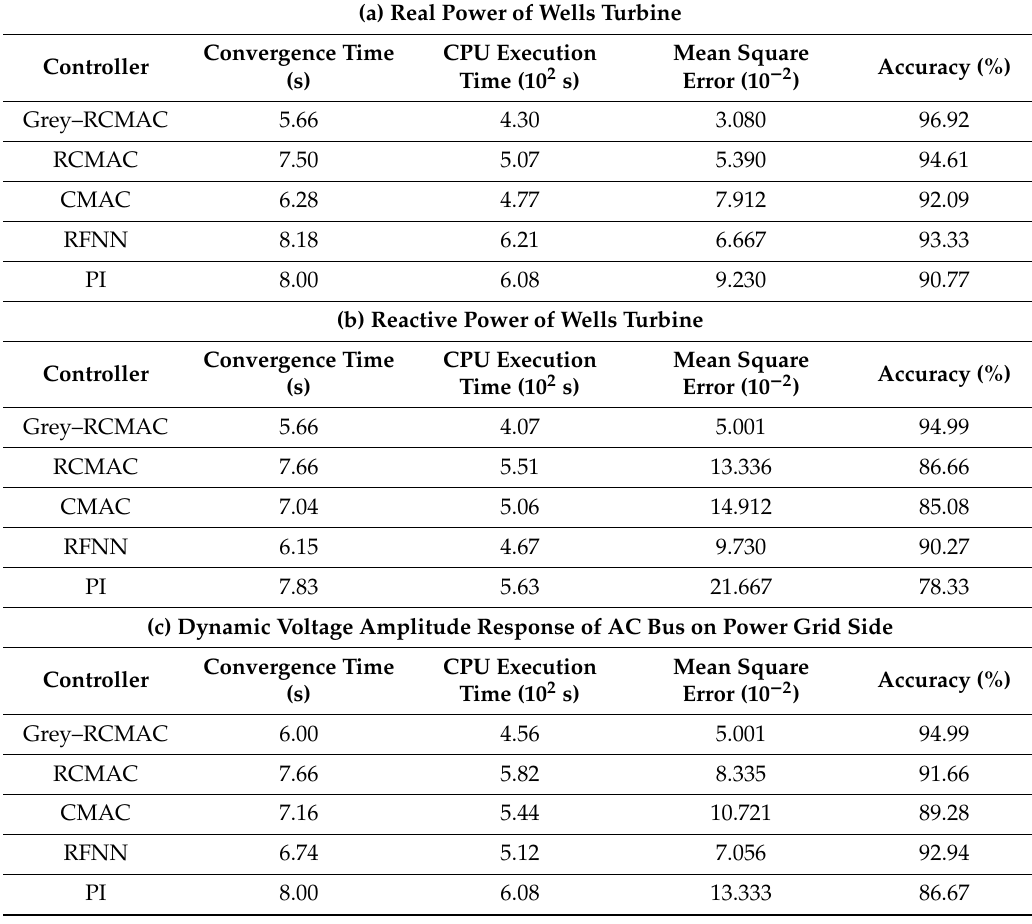
Table 3. Comparison for five methods under the load switching: (a) real power of WECS, (b) reactive power of WECS, and (c) dynamic voltage amplitude response of AC bus on power grid